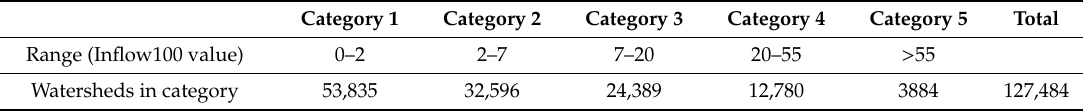
Table 2. Number of threat watersheds in five threat